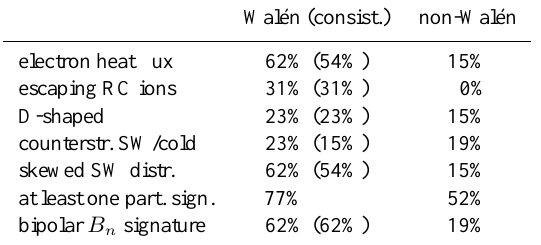
Table 2. Occurrence rate of particle signatures and bipolar B n sig- natures during Wal´en and non-Wal´en events. For the Wal´en events, it is given how often the signature is consistent with Eq. (3) Wal´en